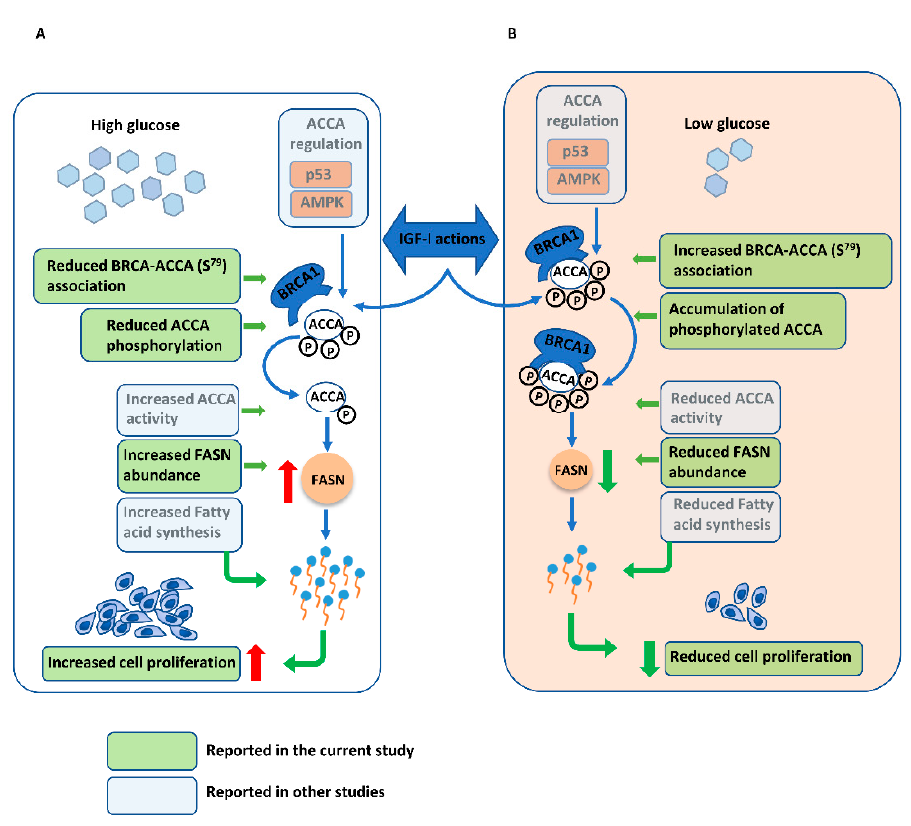
Figure 6. Proposed model of how normal glucose supports breast cancer 1, early onset (BRCA1) function as a metabolic restraint of insulin-like growth factor I (IGF-I) actions. Acetyl CoA carboxylase (ACCA) catalyses a rate-limiting step of the fatty acid synthesis pathway and is partly regulated at a transcriptional level by p53 and post transcriptionally by AMP-activated protein kinase (AMPK) via reversible phosphorylation [15,41]. Its activity depends on the equilibrium between active (dephosphorylated) and less active (phosphorylated) forms [43] and the novel BRCA1 functions in regulating fatty acid synthesis involve binding phosphorylated ACCA and keeping it in this less active form. ( A ) In high glucose conditions, IGF-I impairs this function by reducing the association between BRCA1 and p-ACCA (S 79 ), resulting in ACCA dephosphorylation and increased activity. Downstream of ACCA, IGF-I increases fatty acid synthase (FASN) abundance, leading to increased fatty acid synthesis to support cell proliferation. ( B ). In contrast, the association between BRCA1 and p-ACCA (S 79 ) increases in response to IGF-I in normal glucose conditions, resulting in increased ACCA phosphorylation and reduced activity, suggesting that normal glucose support BRCA1 function. Downstream of ACCA, normal glucose conditions inhibit IGF-I-induced upregulation of FASN and consequently, the proliferative responses to IGF-I are reduced. While our conclusions are based on changes in protein abundance and protein–protein interactions, alterations in the fatty acid synthesis pathway would have to be confirmed by actual measurement of enzyme activity or lipids.